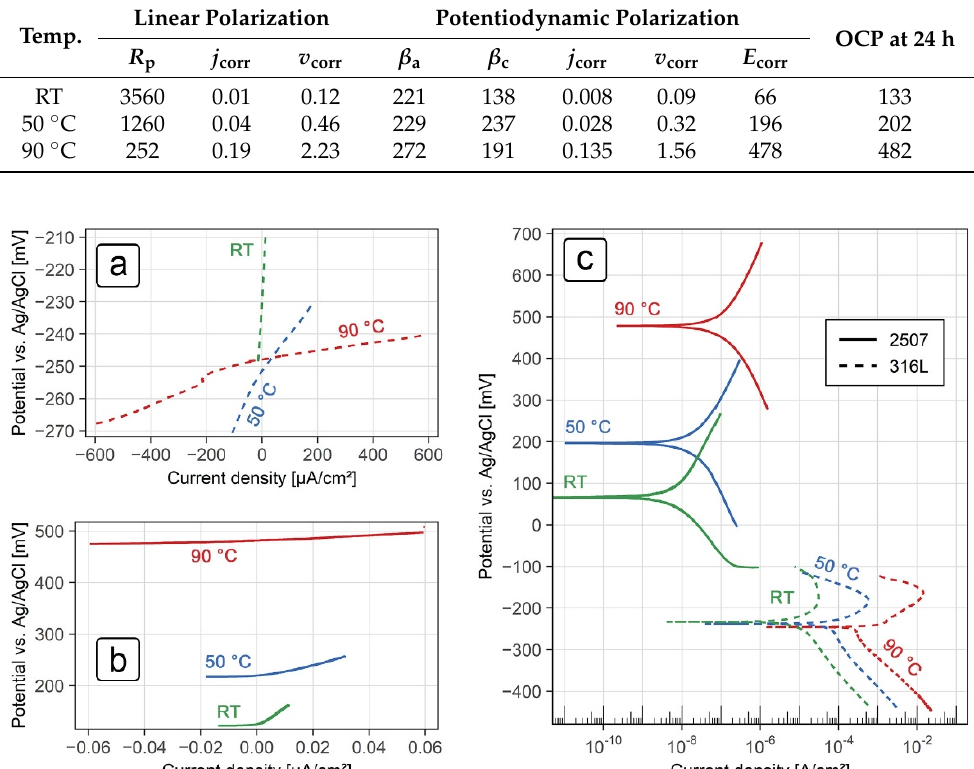
Table 3. Electrochemical parameters ( E corr and OCP (mV), β x (mV), R p (k Ω cm 2 ), j corr ( µ A/cm 2 ) and v corr ( µ m/year)) extracted from OCP, potentiodynamic polarization and linear polarization curves for grade 2507 stainless steel exposed to a 10% H 2 SO 4 solution with 5000 mg/L NaCl at various temperatures. Linear Polarization Temp.